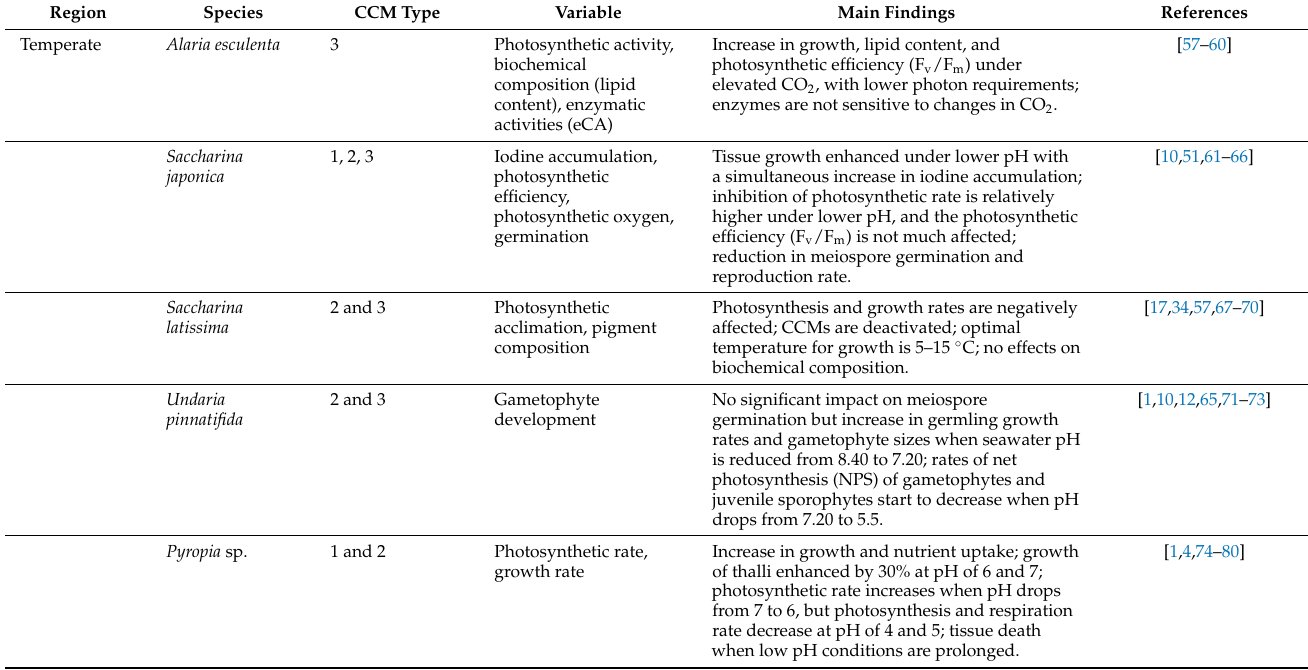
Figure 3. A conceptual diagram, which consists of various aquaculture aspects aimed at sustaining the productivity of aquacultured seaweeds under OA scenarios. the productivity of aquacultured seaweeds under OA scenarios. Table 1. The impact of OA on seaweed species in temperate and tropical regions. The CCMs of types 1 to 3 are described in Section